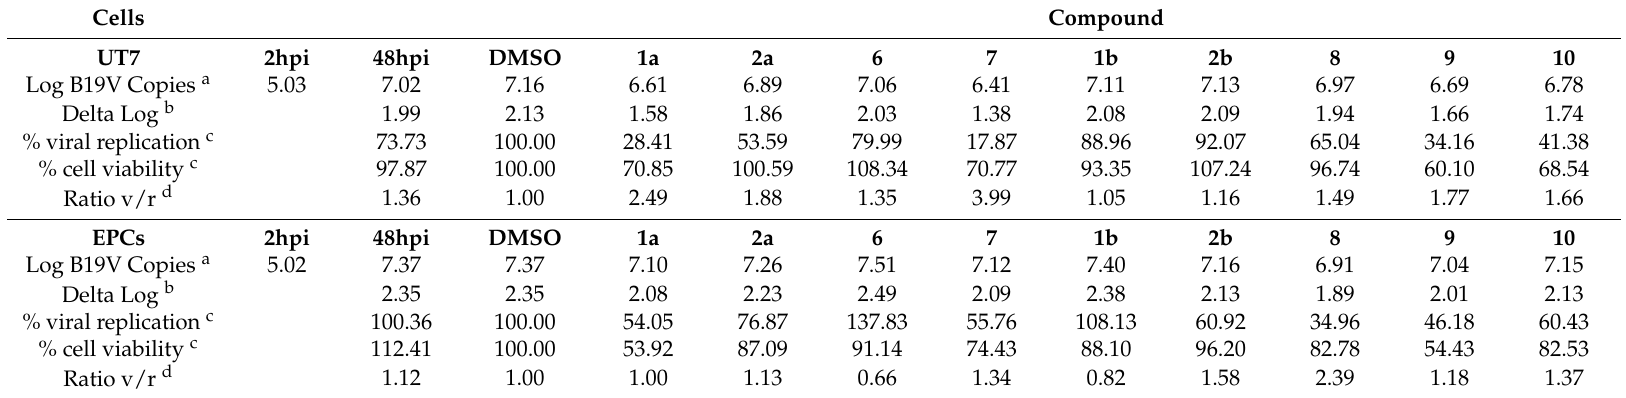
Table 3. Inhibition of viral replication and reduction in cell